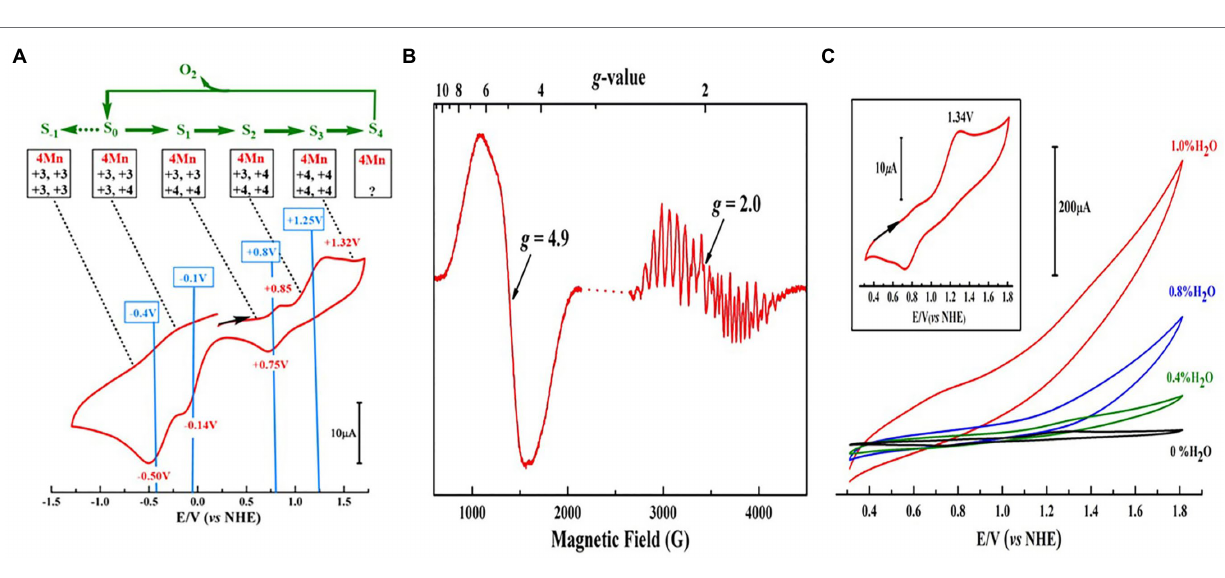
FIGURE 6 | Redox properties, EPR, and catalytic activity measurements of Mn 4 CaO 4 -complex ( 4 ) (Zhang et al., 2015). (A) Cyclic voltammogram (CV) measurement of 4 in dichloroethane; (B) EPR spectrum for the one-electron oxidized 4 ; (C) activity measurements of 4 in acetonitrile with different amounts of H 2 O. The inset in C shows the CV of 4 without H 2 O on a different